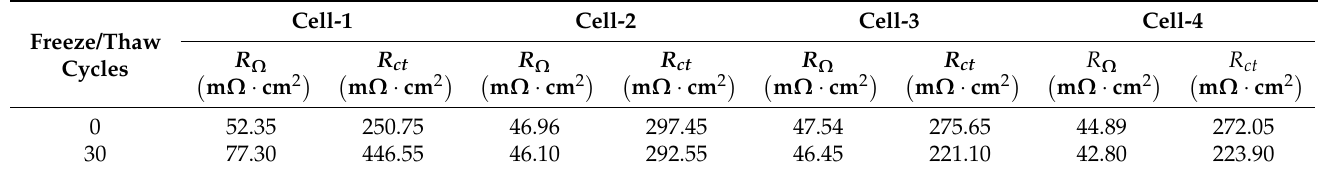
Figure 7. Impedance spectra of single cells before and after 30 freeze/thaw cycles with different initial membrane water content: ( a ) cell-1 with λ = 14; ( b ) cell-2 with λ = 12.0; ( c ) cell-3 with λ = 10.0; ( d ) cell-4 with λ = 8.2. Table 4. The EIS fitting data at 1 A·cm − 2 before and after freeze/thaw cycles.